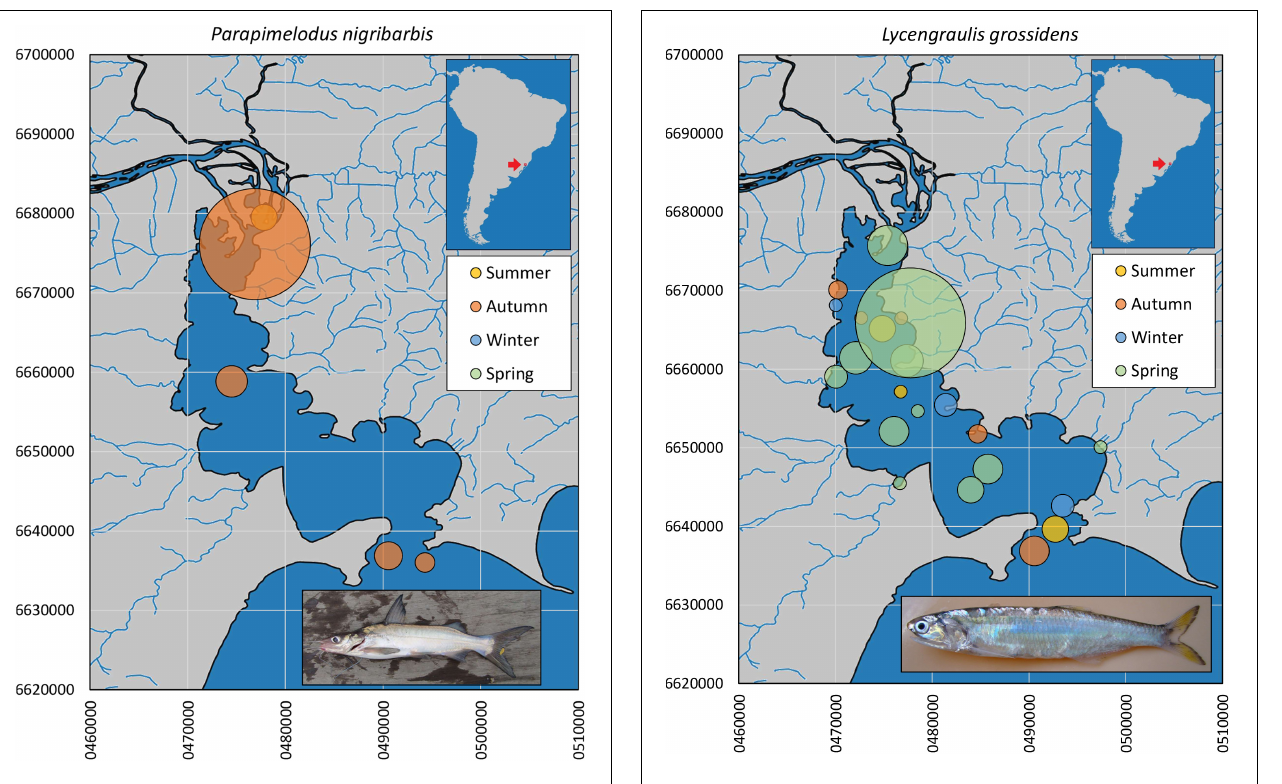
FIGURE 4 | Spatial and seasonal relative abundance of P. nigribarbis in Guaíba Lake, southern Brazil. Bubble area proportional to number of captures per site ( n = 149 individuals). Fish photograph from Timm, C.D. available at Fishbase.com. Vector map background from FEPAM open database (http://www.fepam.rs.gov.br/biblioteca/geo/bases_geo.asp). 22J UTM coordinates.